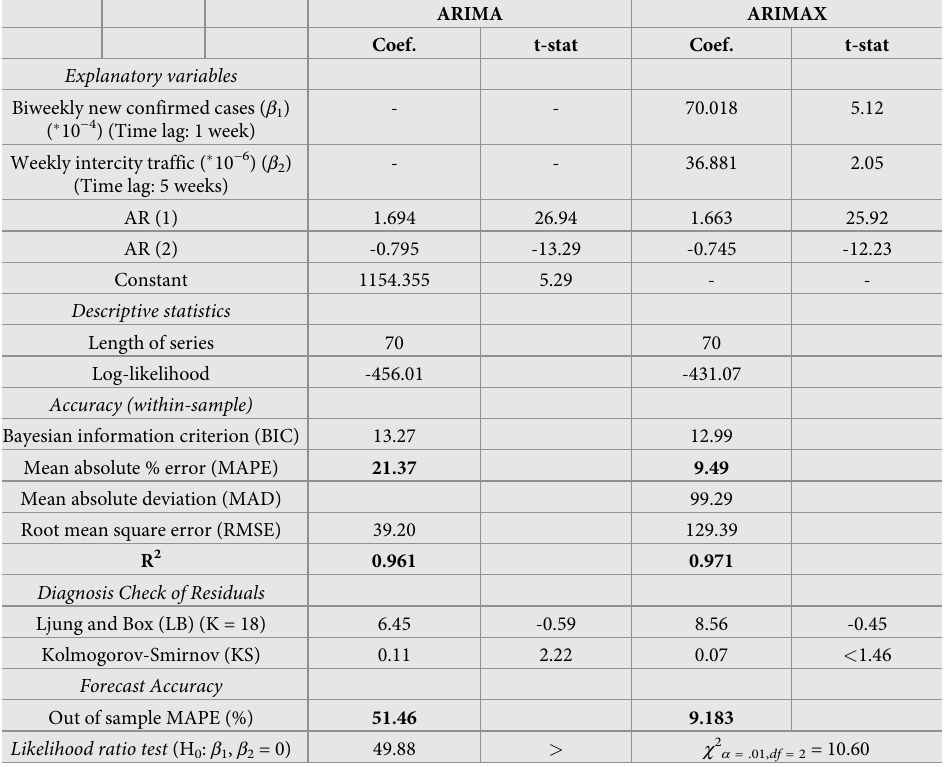
Table 3. Weekly new COVID deaths forecasting models.